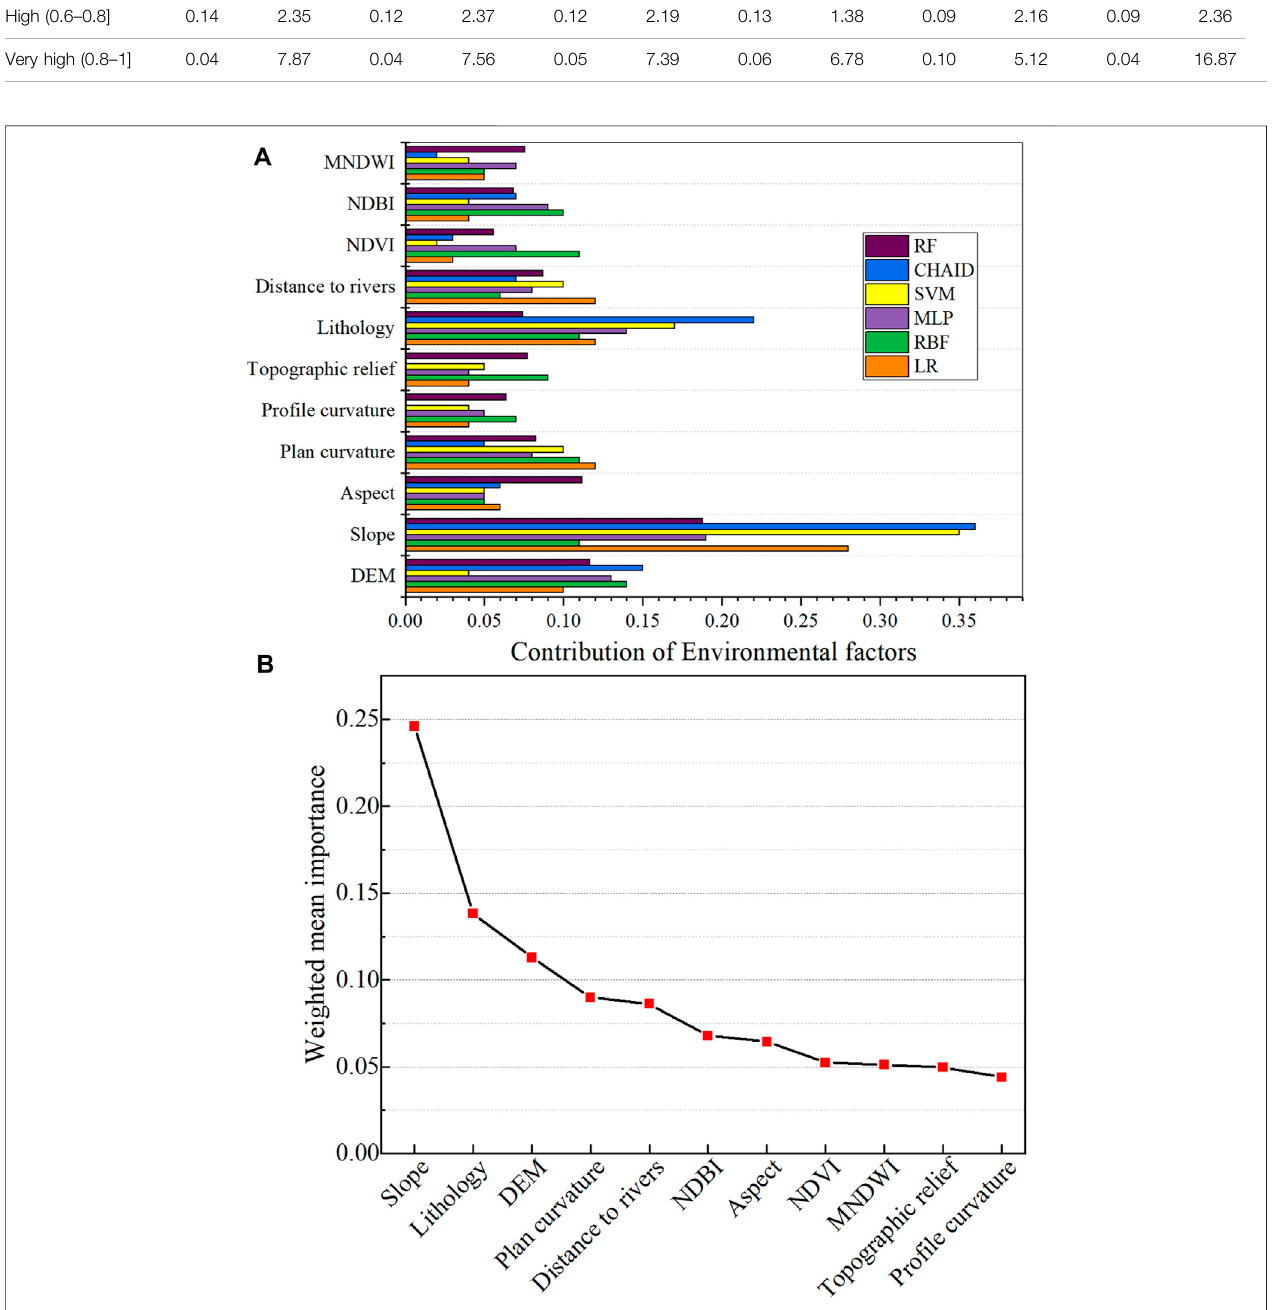
FIGURE 7 | Importance of environmental factors. (A) Relative importance of environmental factors in different models. (B) Average importance of environmental factors under different models. Frontiers in Earth Science |